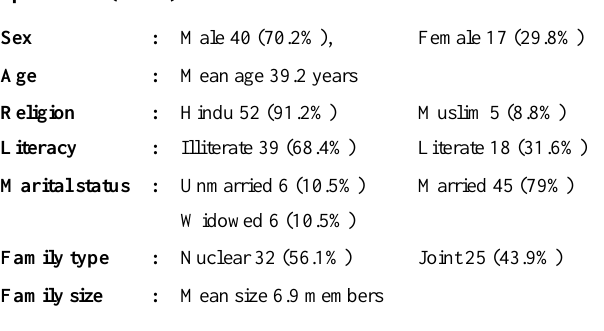
Table II: Main social characteristics of the sample study population (n=57)